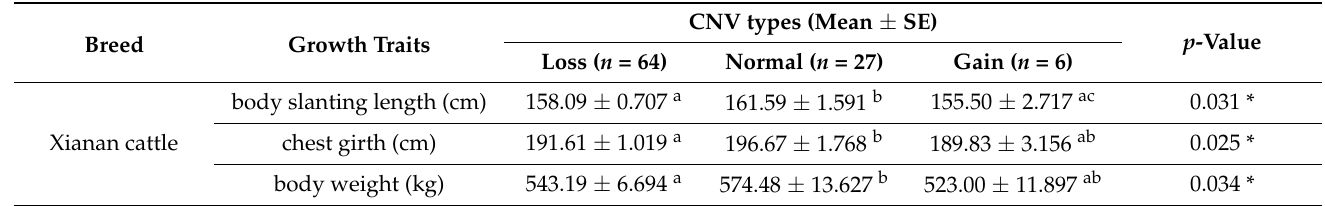
Table 3. Association analysis of CLCN2 gene CNV2 with growth traits in XN cattle.